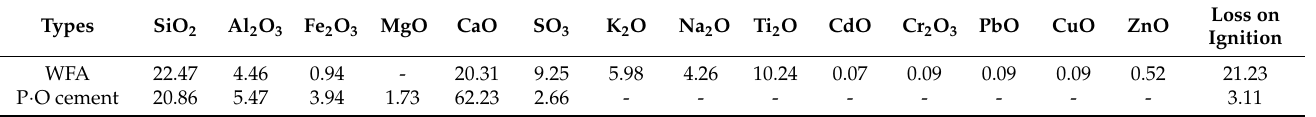
Table 1. Chemical composition of the cementitious